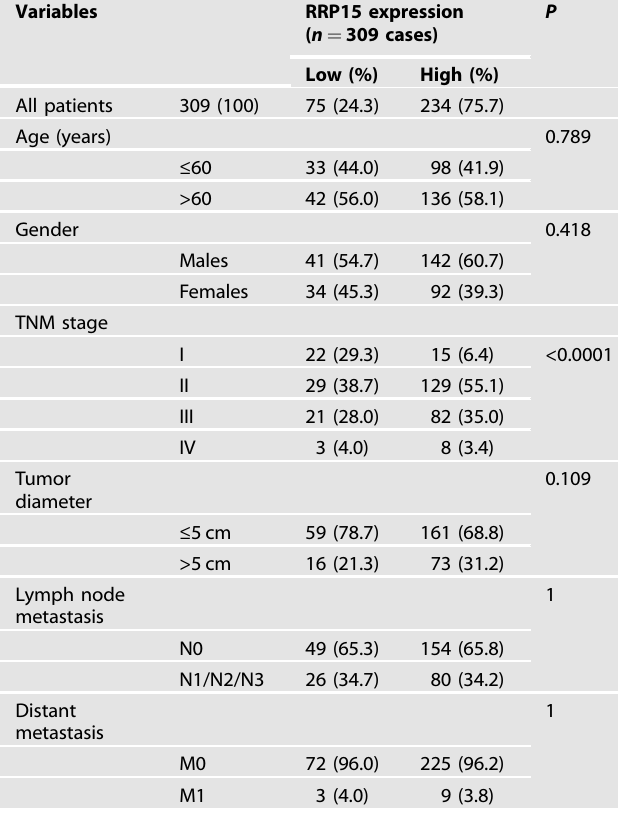
RRP15, a ribosome RNA processing protein presented in the nucleolus, plays critical roles in RiBi via controlling pre-rRNA